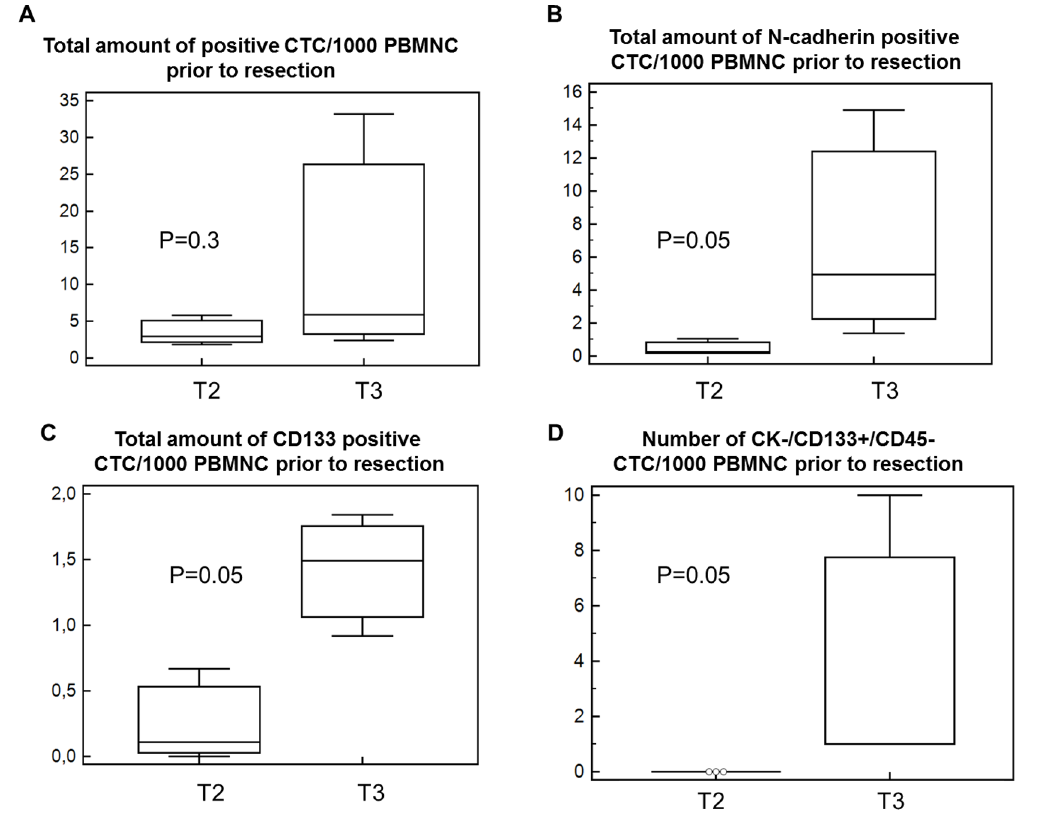
Figure 5. Association between CTC subtypes and tumor staging. A ) Mann-Whitney test showed that he total amount of CTC was elevated in T3 patients compared to T2, but the difference did not reach level of significance. B–C ) Prior to resection, the amount of N-cadherin-positive (mesenchymal) and CD133-positive (stem cell-like) CTC was significantly higher in stage T3 compared to T2 patients (both p 5 0.05). D ) Stem cell-like CK 2 /CD133 + /CD45 2 cells were only present in stage T3 patients.